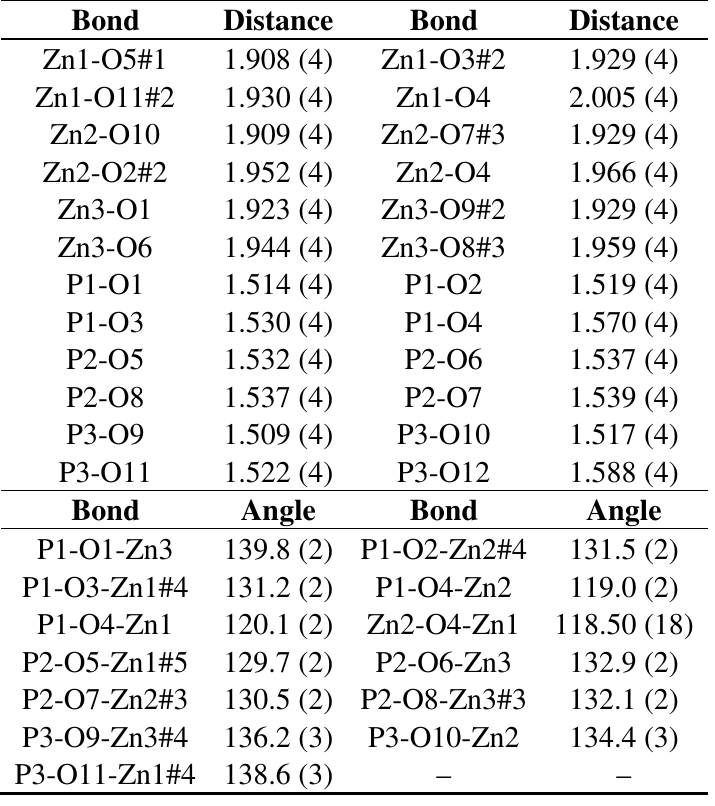
Table 3. Selected geometrical data (Å and ° ) for 2